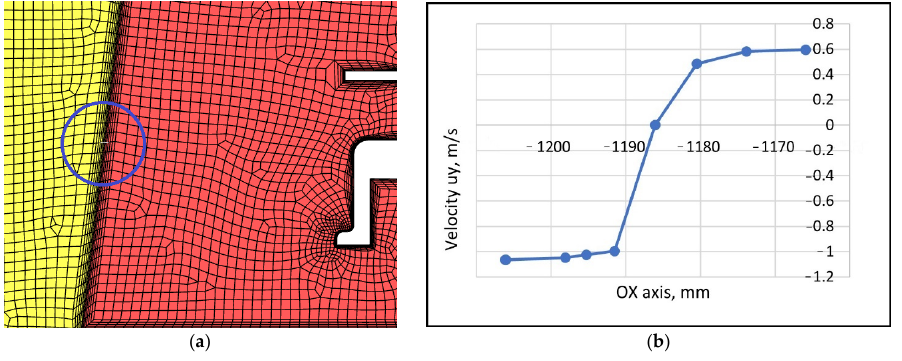
Figure 15. Velocity near the wall: ( a ) region; ( b ) velocity.